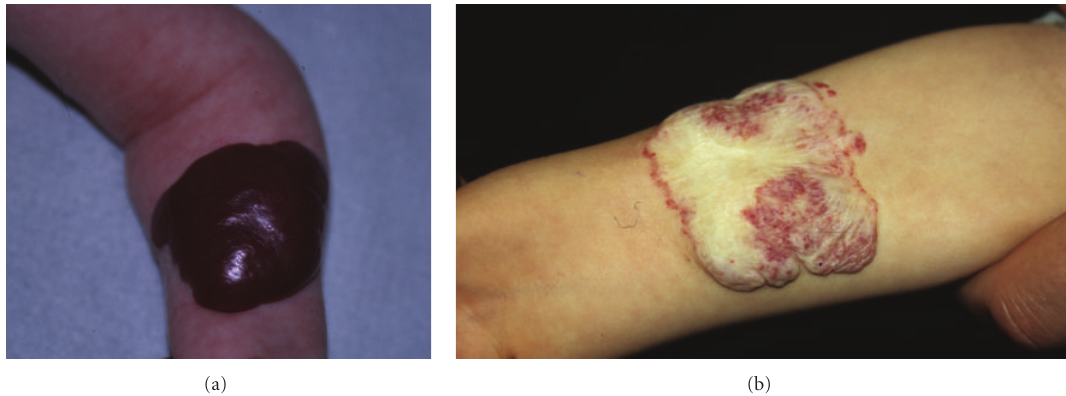
Figure 3: Infant 8 with haemangioma of the forearm before and after 3 treatments with